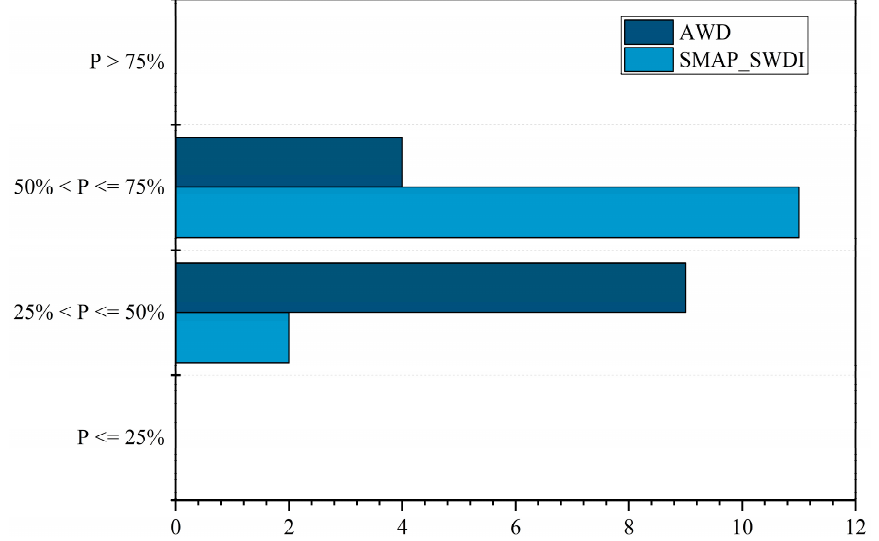
Figure 9. Distribution of the PDWs of atmospheric water deficit (AWD) and SMAP_SWDI in four intervals.